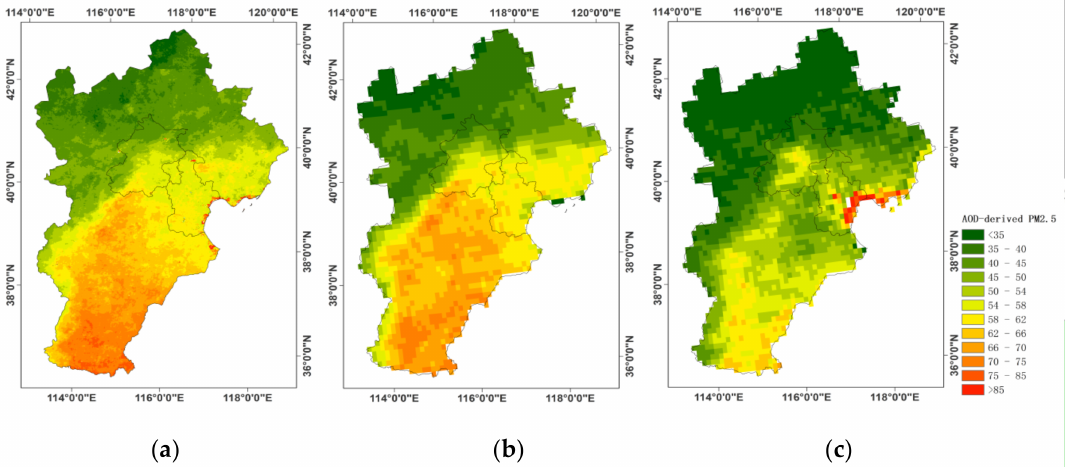
Figure 7. The annual mean satellite predicted PM 2.5 in the BTH during 2017 from ( a ) MAIAC, ( b ) DB, and ( c ) DT